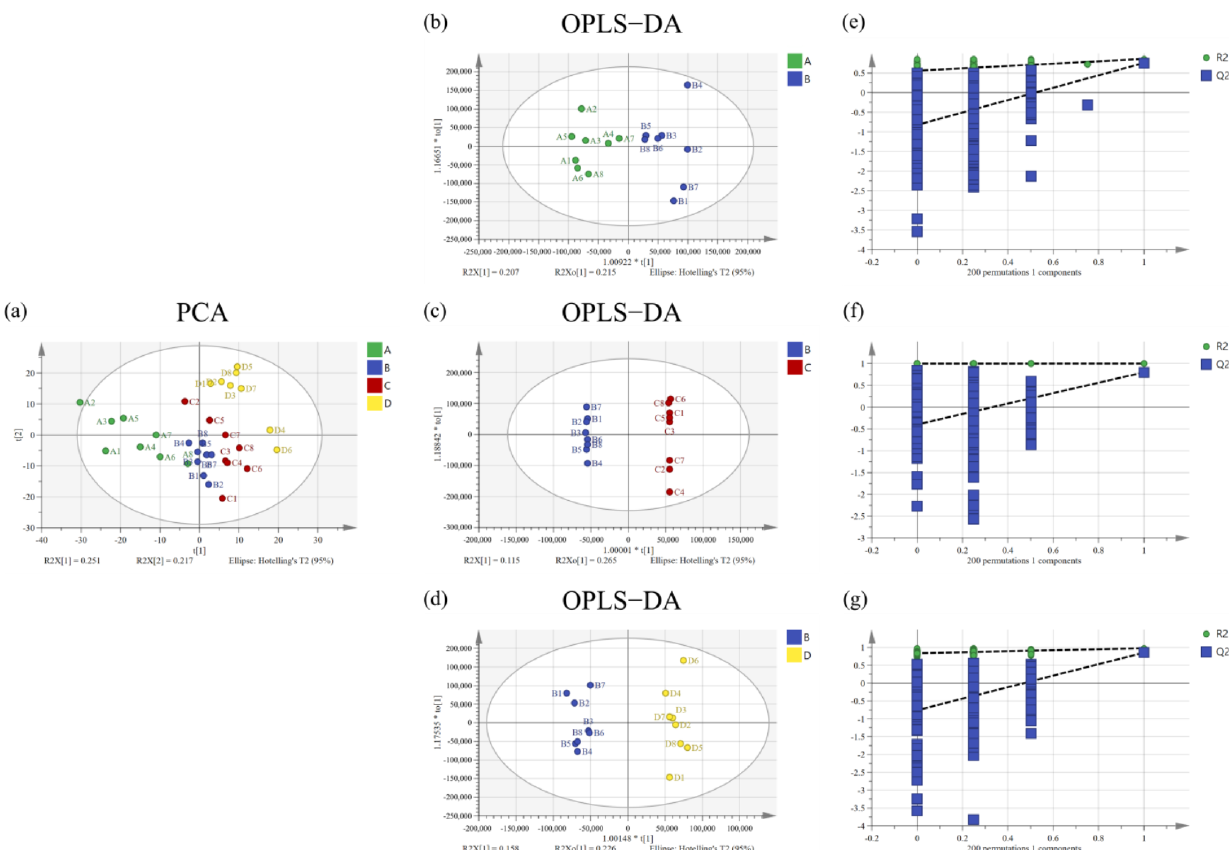
Figure 3. Principal component analysis score plot (PCA), ( a ), orthogonal partial least squared- discriminant analysis (OPLS-DA) score plot ( b – d ), and permutation plot (200 permutations), ( e – g ) of serum samples collected from the normal group ( A ), model group ( B ), positive group ( C ), and peppermint essential oil group ( D ), ( n = 8).